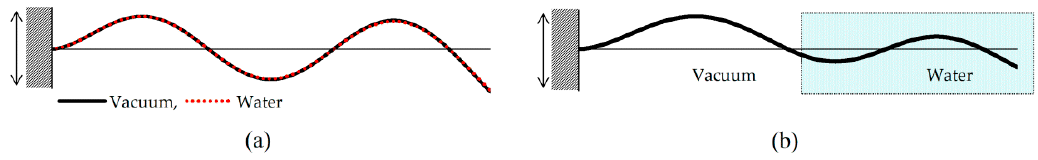
Figure 4. The standing wave pattern at the fourth resonance frequency of the cantilever when ( a ) fully immersed in vacuum and water and ( b ) half-immersed in water.